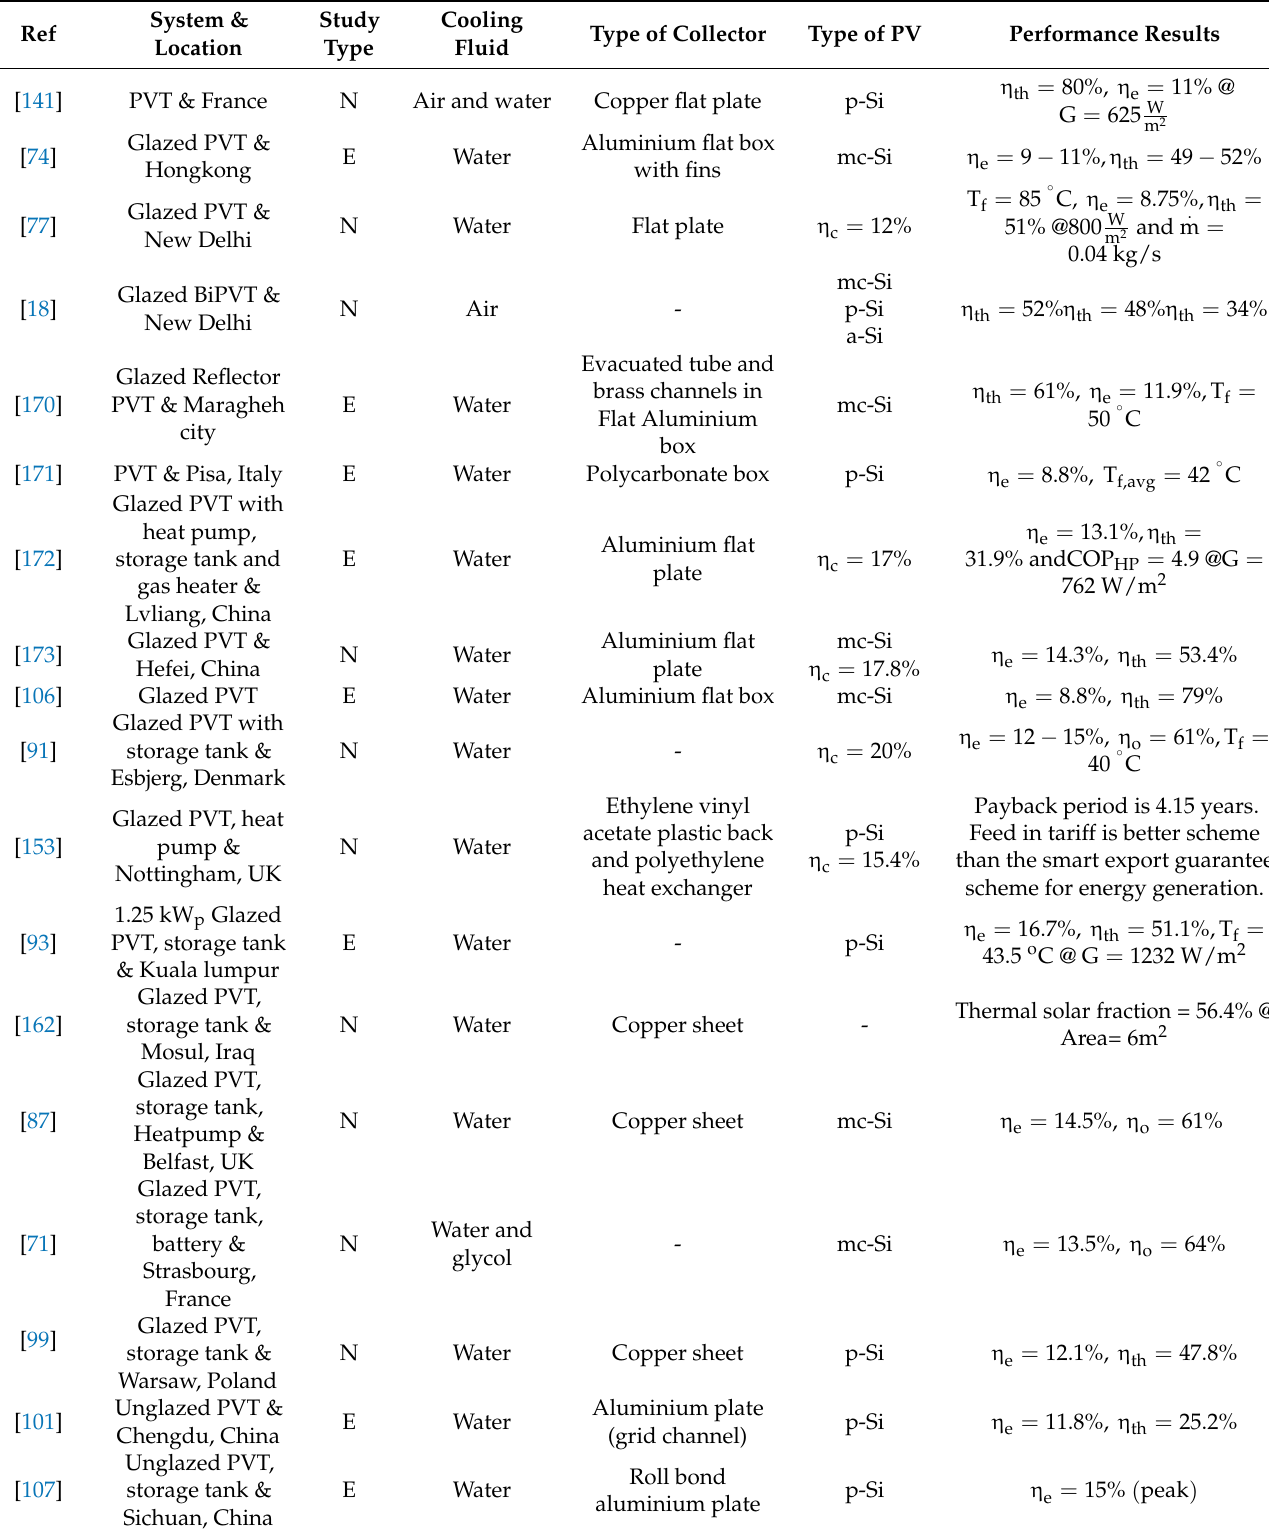
Table 4. Summary of the PVT